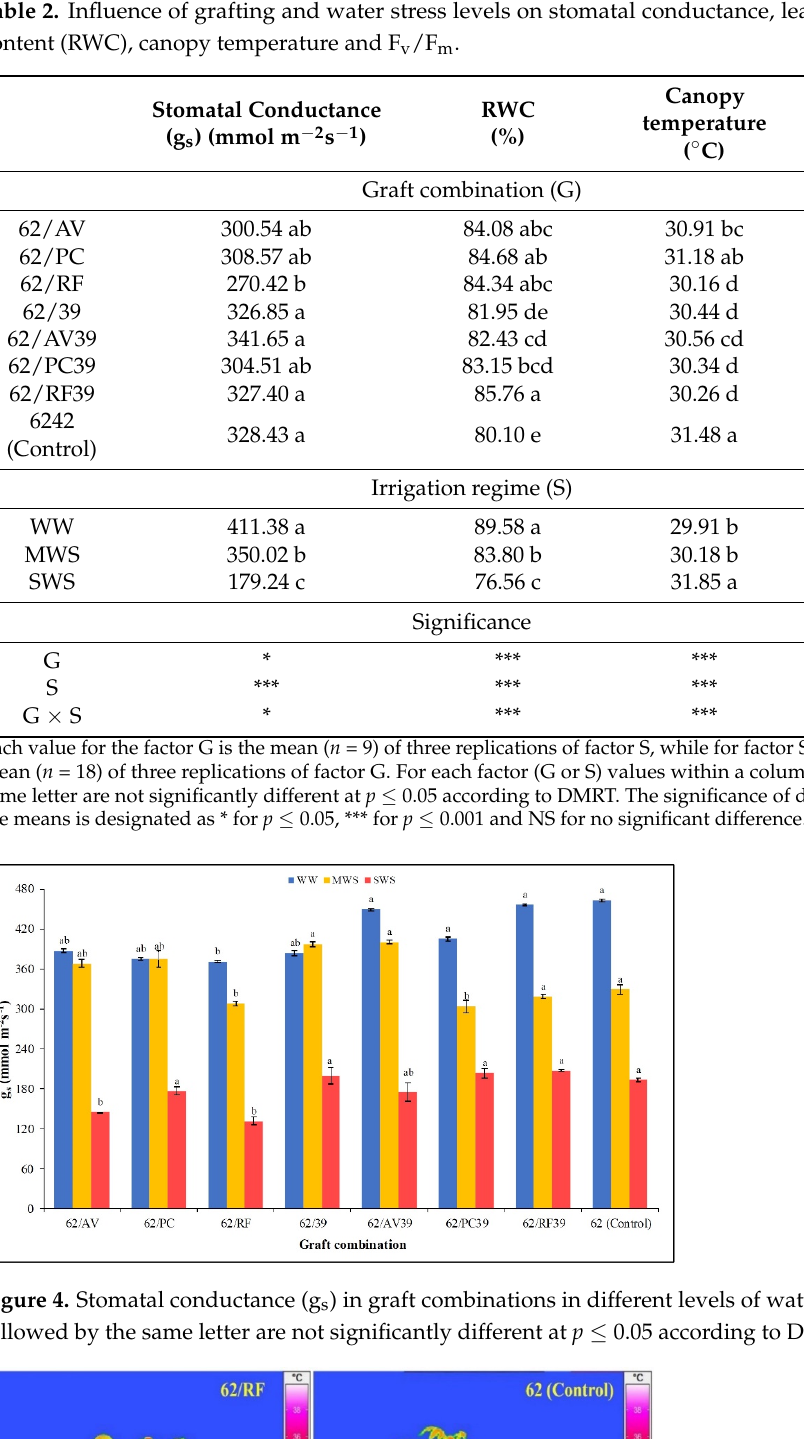
Table 2. Influence of grafting and water stress levels on stomatal conductance, leaf relative water content (RWC), canopy temperature and F v /F m .